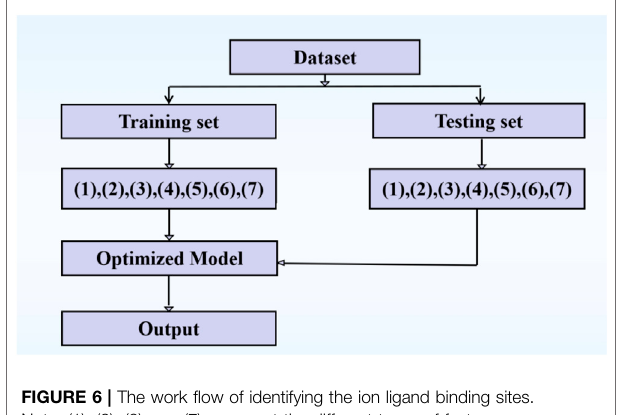
FIGURE 6 | The work fl ow of identifying the ion ligand binding sites. Note: (1), (2), (3), ... , (7) represent the different types of features.